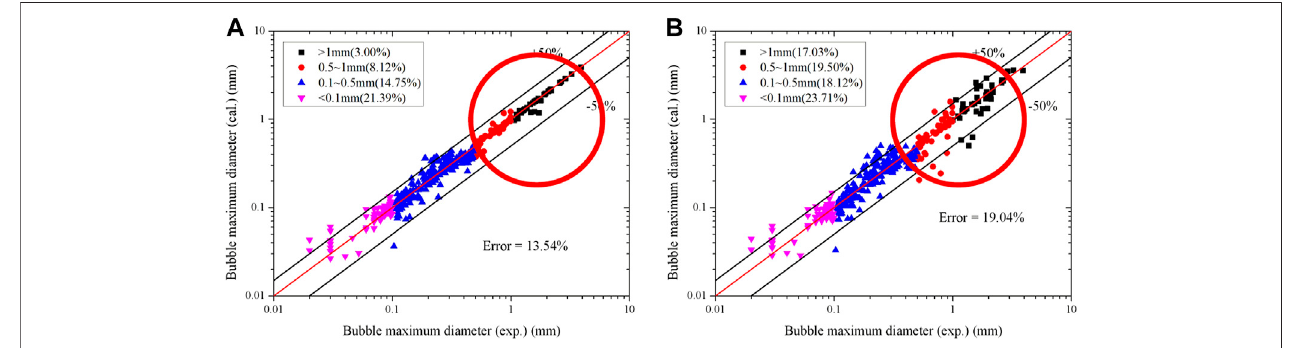
FIGURE 6 | The distributions of bubble maximum diameter for different ranges of size. (A) Excluding the measurement error of P , (B) including the measurement error of